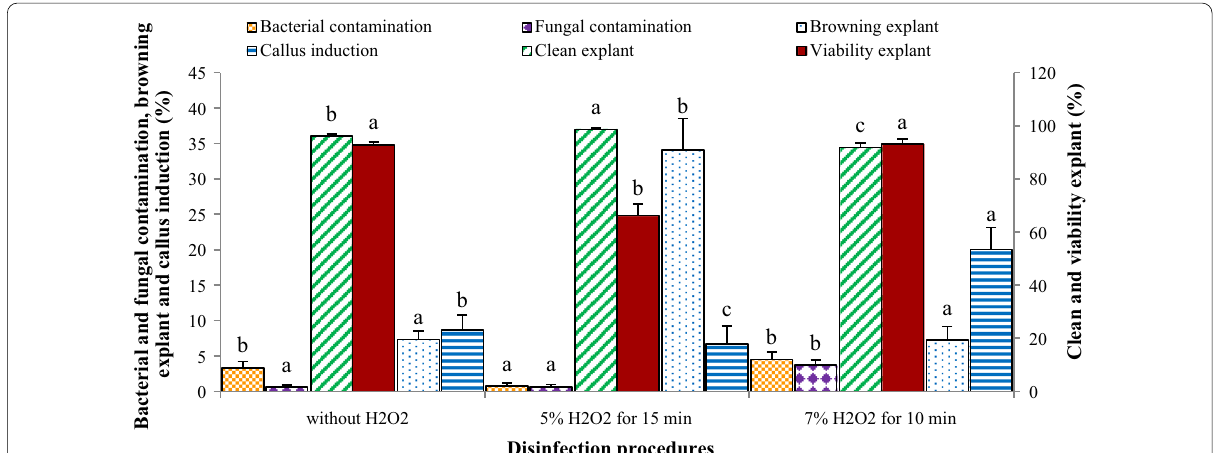
Fig. 4 The effect of H 2 O 2 inclusion and concentration in disinfection protocol on the M. azedarach L. leaf explants contamination and viability. Bars with different letters indicate a significant difference ( P 5%) according to Duncan’s Multiple-Range Tests (DMRTs) ≤